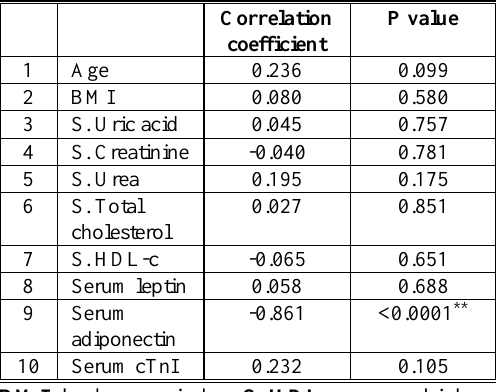
Table 4: Correlation between serum resistin level and selected demographic and laboratory variables in STEMI patients.